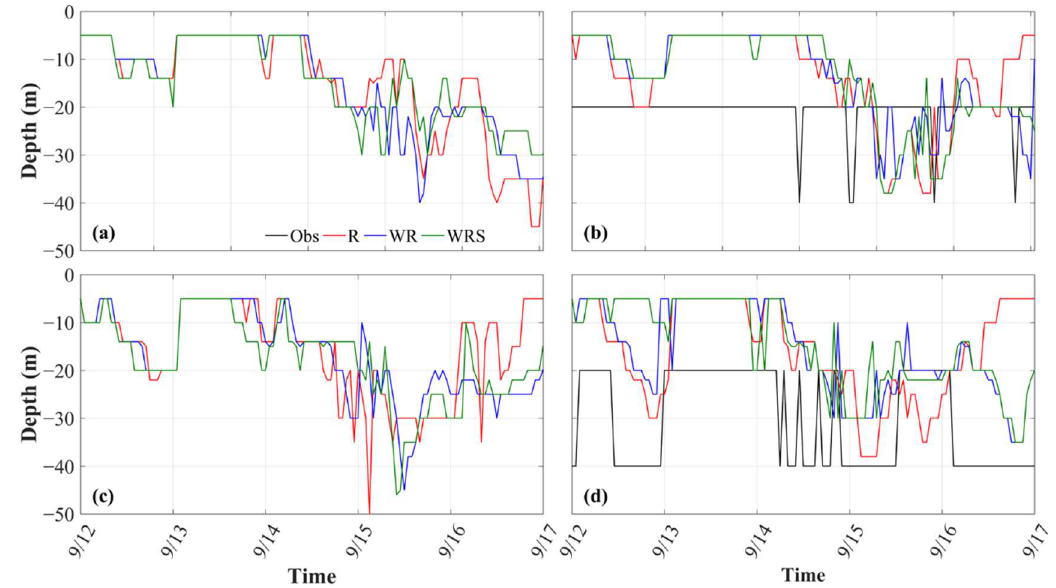
Figure 15. Comparison between observed and simulated mixed layer depth (m) at ( a ) Buoy 1; and ( b ) Buoy 2; ( c ) Buoy 4; and ( d ) Buoy 5. Observation (black), R (red), WR (blue) and WRS (green). Note that only observations at Buoys 2 and 5 are available.